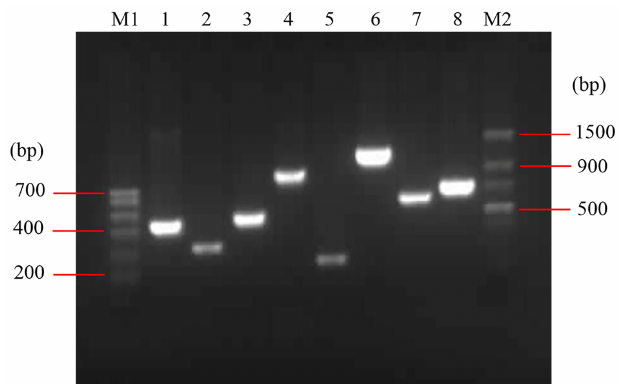
Figure 1. Identification of virulence factors in E. coli O78 (CVCC CAU0768). M1: Trans DNA